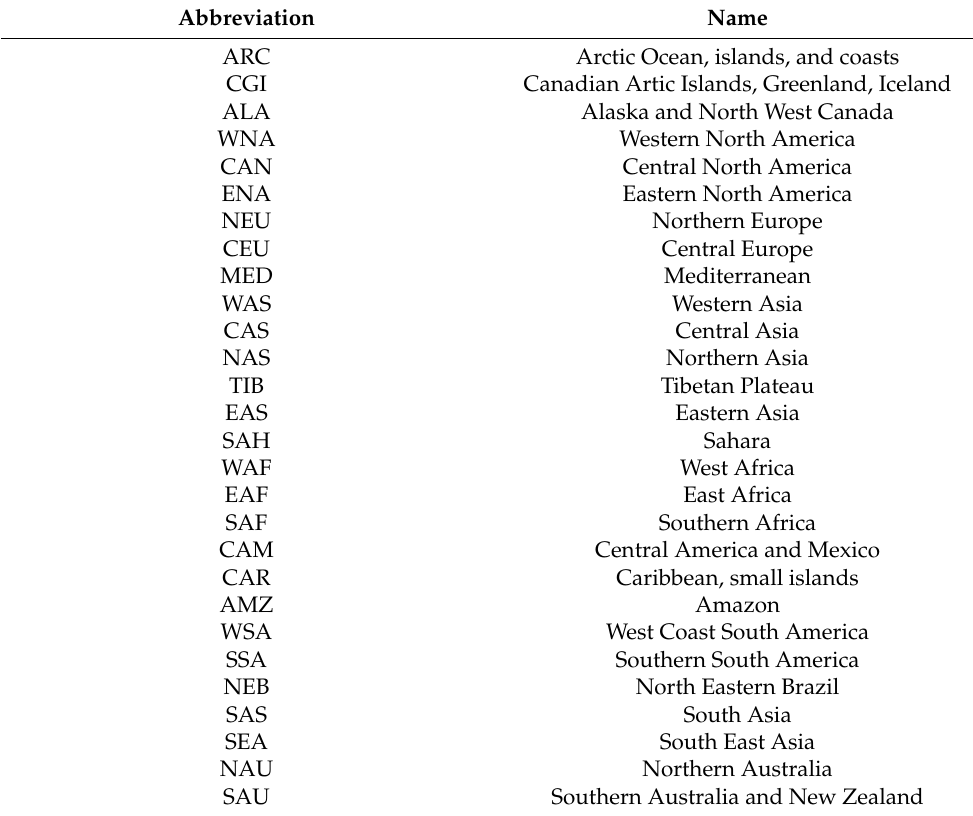
Table A1. Names and abbreviations of IPCC macro